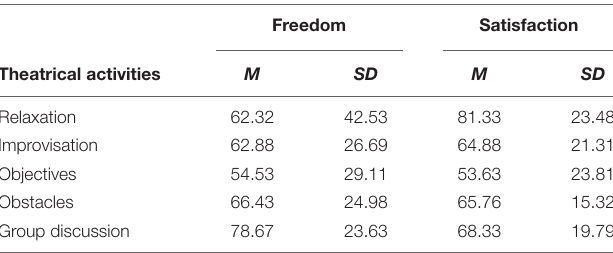
TABLE 2 | Means and standard deviations for perceptions of freedom and satisfaction of theatrical activities practiced ( N = 16).